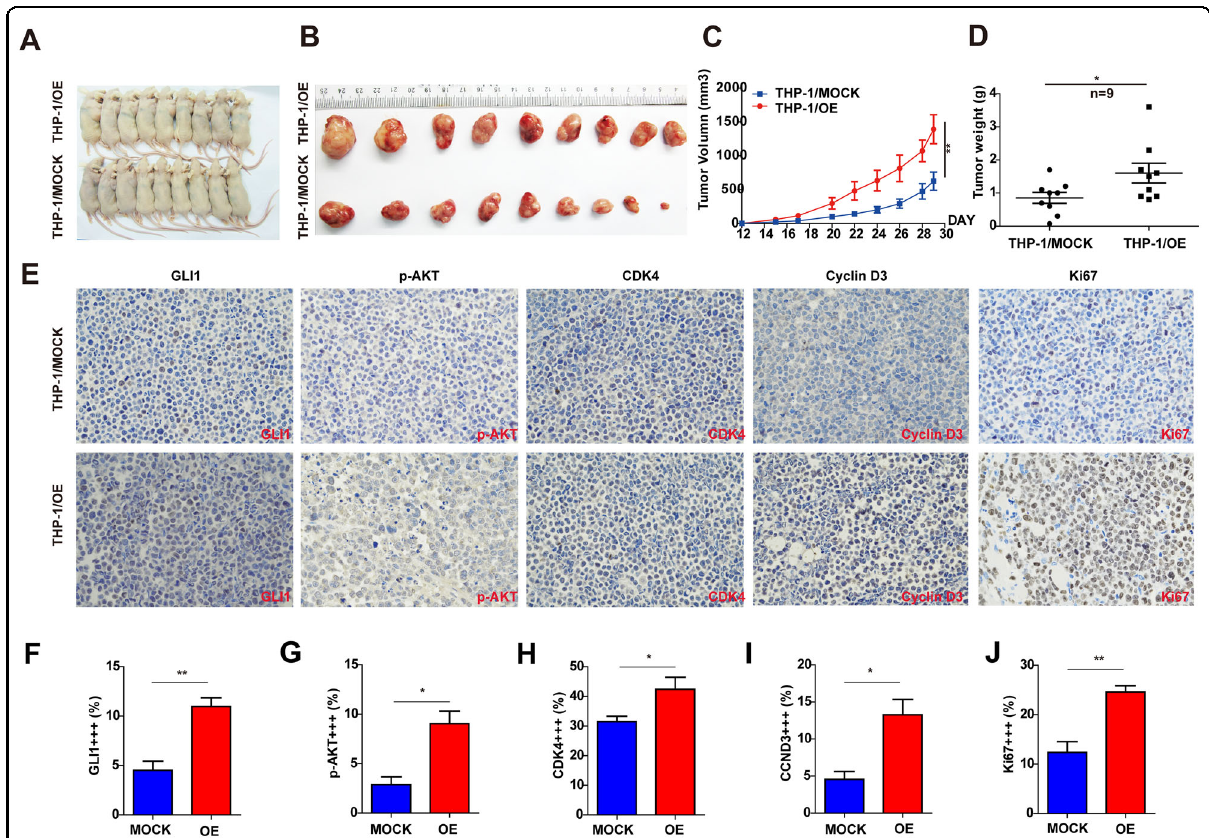
Fig. 4 GLI1 signi fi cantly promotes tumor growth in an animal model. A , B Images of xenograft mice ( A ) and tumors ( B ) from mice injected with THP-1/OE and THP-1/MOCK cells (OE and MOCK: n = 9). C , D The volumes ( P = 0.0022) and weights ( P = 0.0370) of tumors harvested from xenograft mice injected with THP-1/OE and THP-1/MOCK cells. The p values for the tumor volumes were obtained by two-way ANOVA. The p values for the tumor weights were obtained by a two-tailed Student ’ s test. E Representative IHC staining images of the GLI1, p-AKT, cyclin D3, CDK4, and Ki67 expression levels in xenograft tumor tissues. F – J The strong positive ( +++ ) signals from GLI1, p-AKT, Cyclin D3, CDK4, and Ki67 staining were quanti fi ed. The p values were obtained by a two-tailed Student ’ s t -test * P < 0.05, ** P < 0.01, *** P < 0.001, ns not signi fi